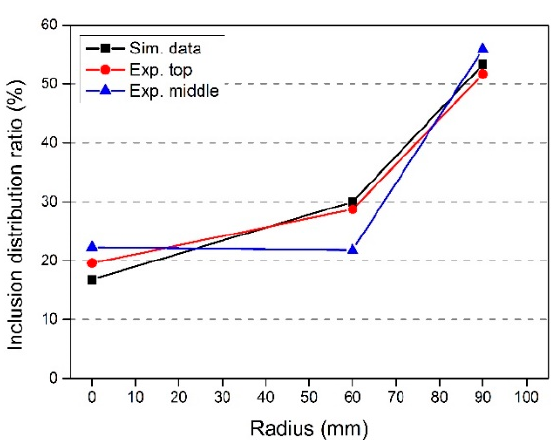
Figure 9. Comparison of distribution ratio of inclusions along radius direction between simulation and experiment.